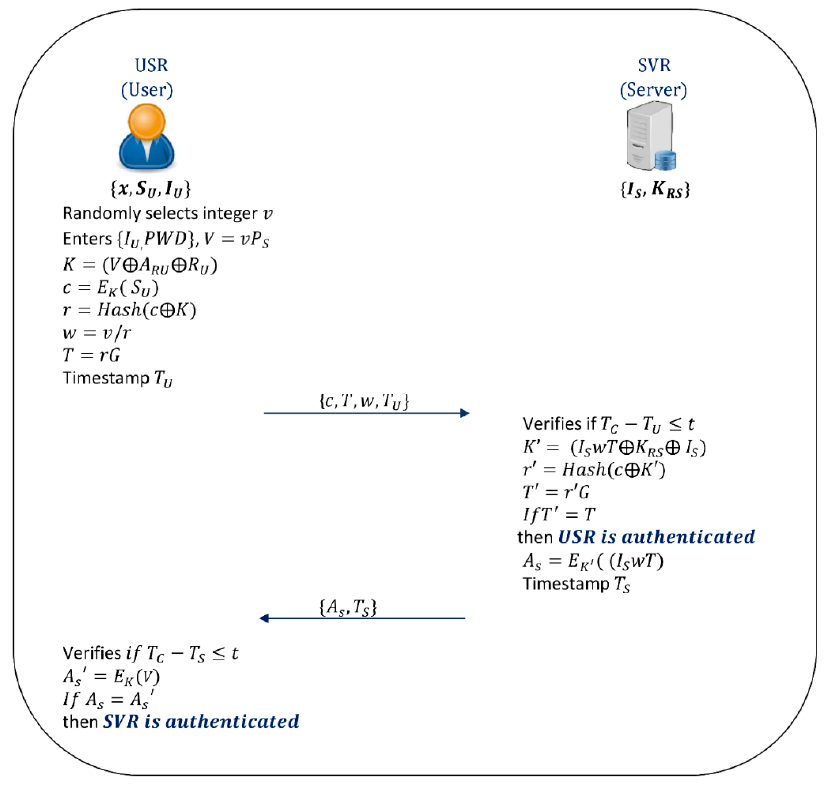
Figure 6. Signcryption-based Mutual Authentication Phase in ECSSP-SC.